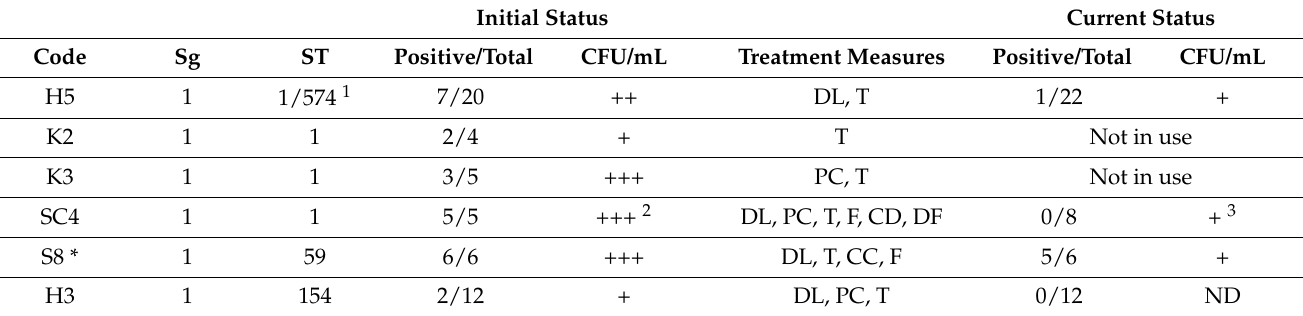
Table 2. Summary of the culture status and characterisation of L. pneumophila in culture-positive shower systems in Stavanger municipality. The shower systems are initially sorted into sg1 or sg2–14 and then by ST within the sg